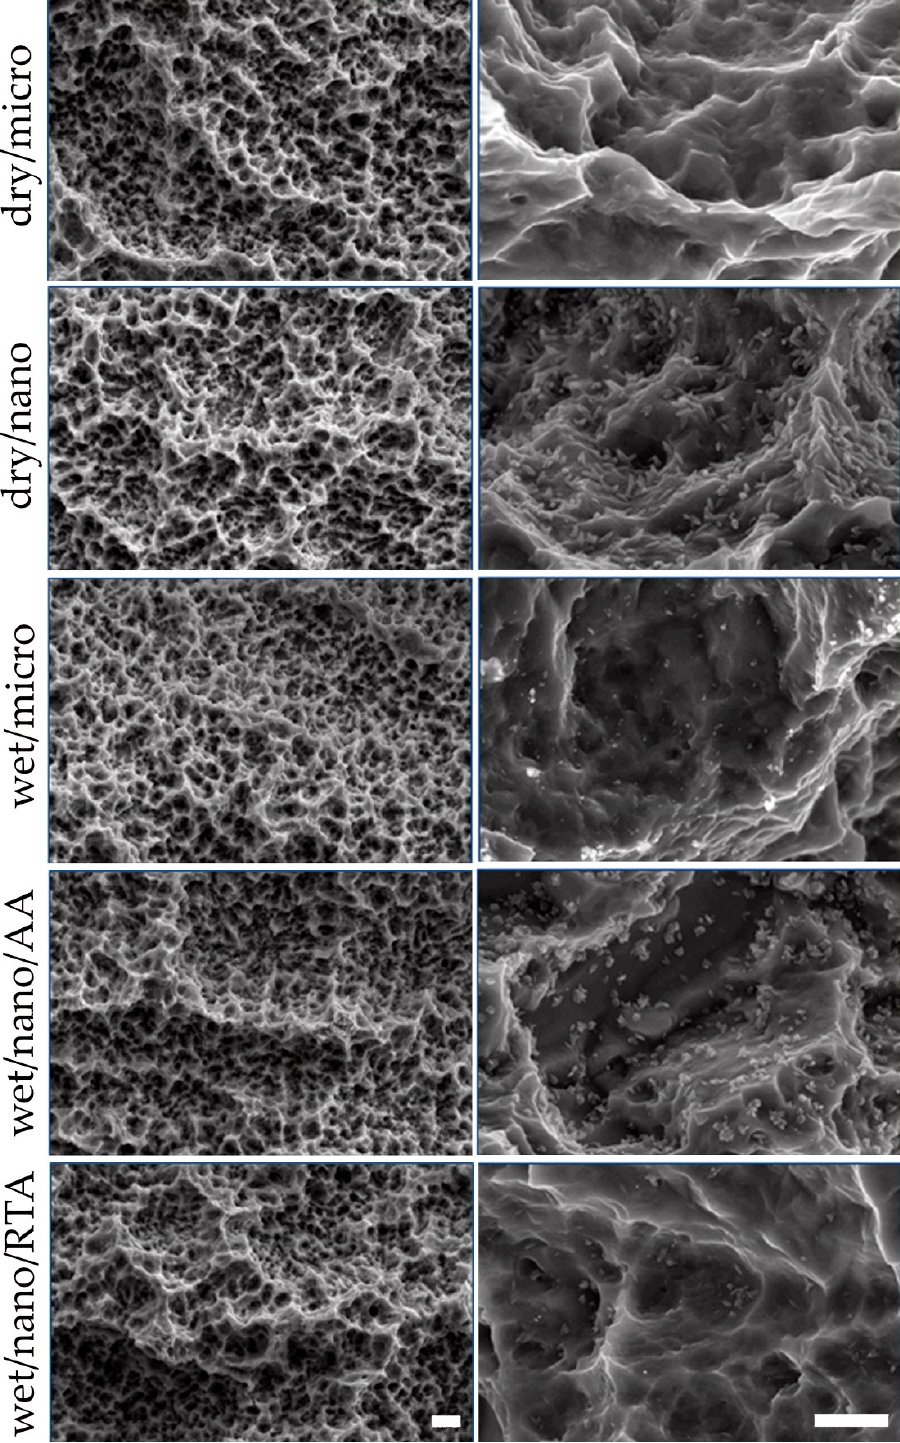
Figure 1. SEM images demonstrating comparative surface morphologies of micro ‐ versus nano ‐ structured materials. Left column: Low magnification showing macro ‐ roughness; Scale bar = 4 μ m; Right column: High magnification showing micro ‐ and nano ‐ roughness; Scale bar = 400 nm.